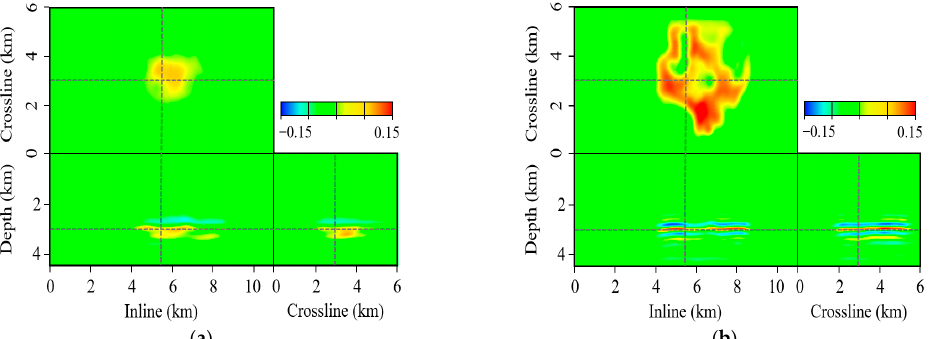
Figure 8. Monitoring results by subtracting two RTM images from the baseline and post-injection survey with ( a ) mode I (conventional) and ( b ) mode V (small-angle) of DAF. The inverted velocity model (Figure 6a) using conventional FWI is used.